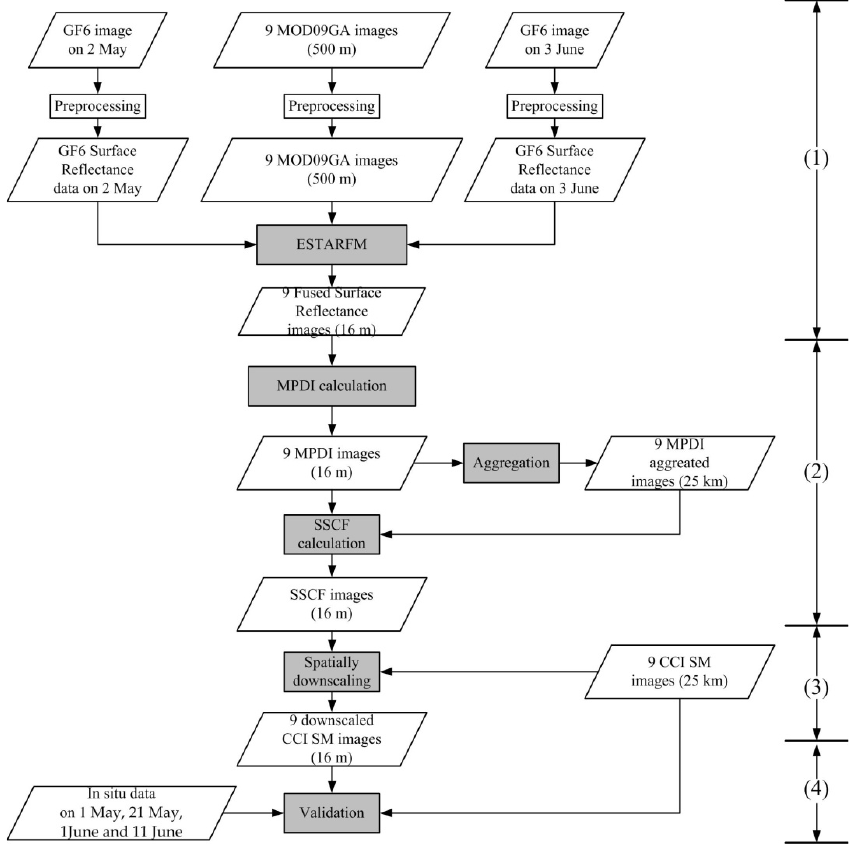
Figure 3. Research flowchart of the proposed method.